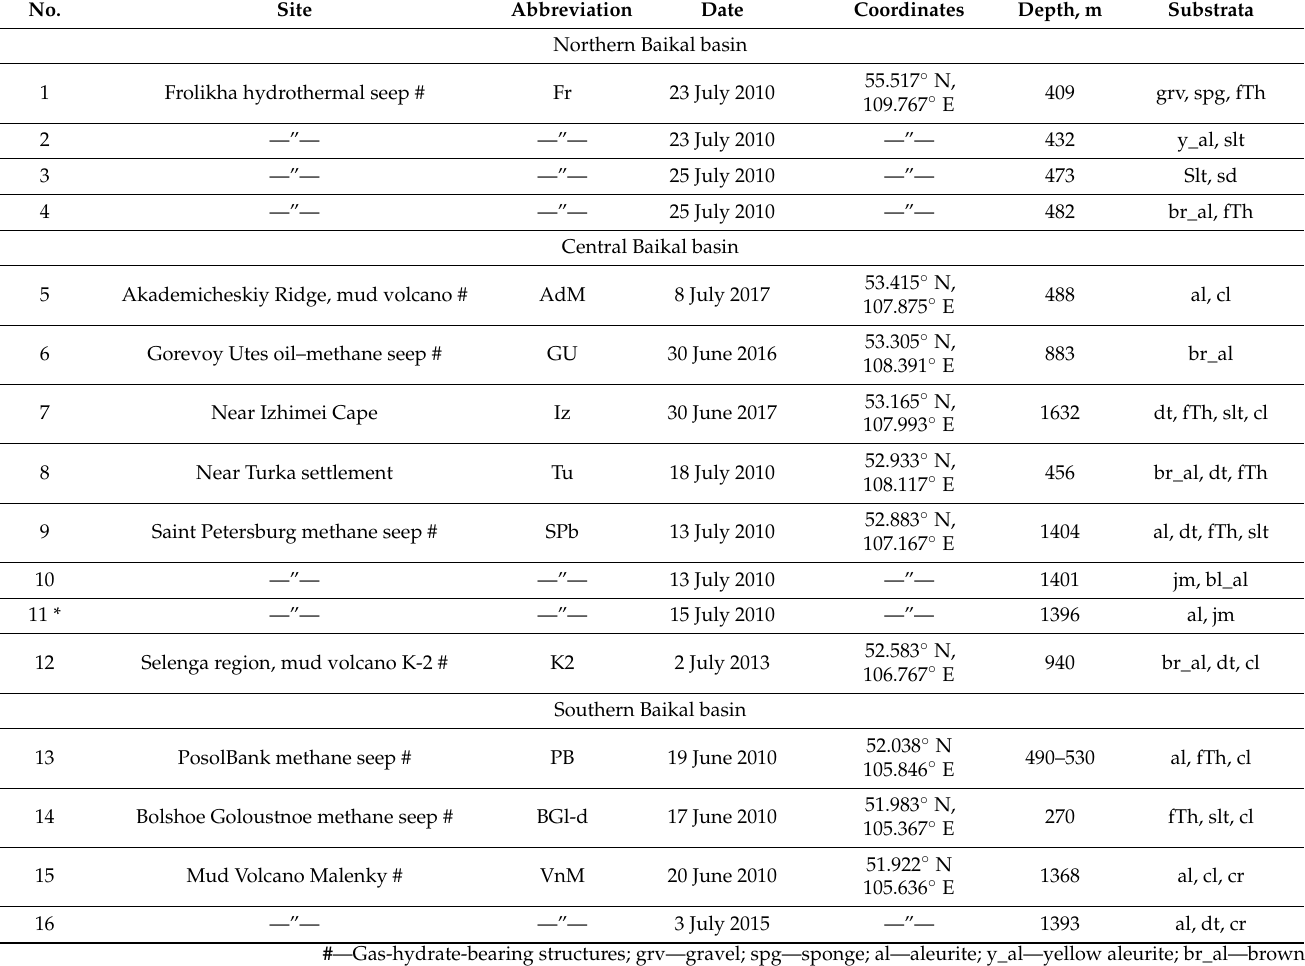
Table 1. Information regarding investigated samples from the deep-water zone of Lake Baikal.